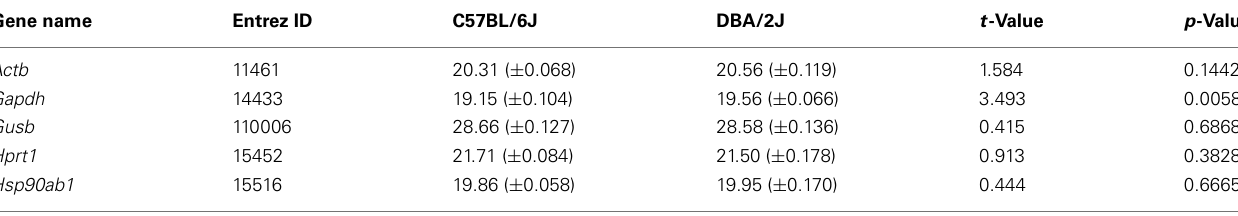
Table 2 | Cycle thresholds (CTs) for the five housekeeping genes included on the array.